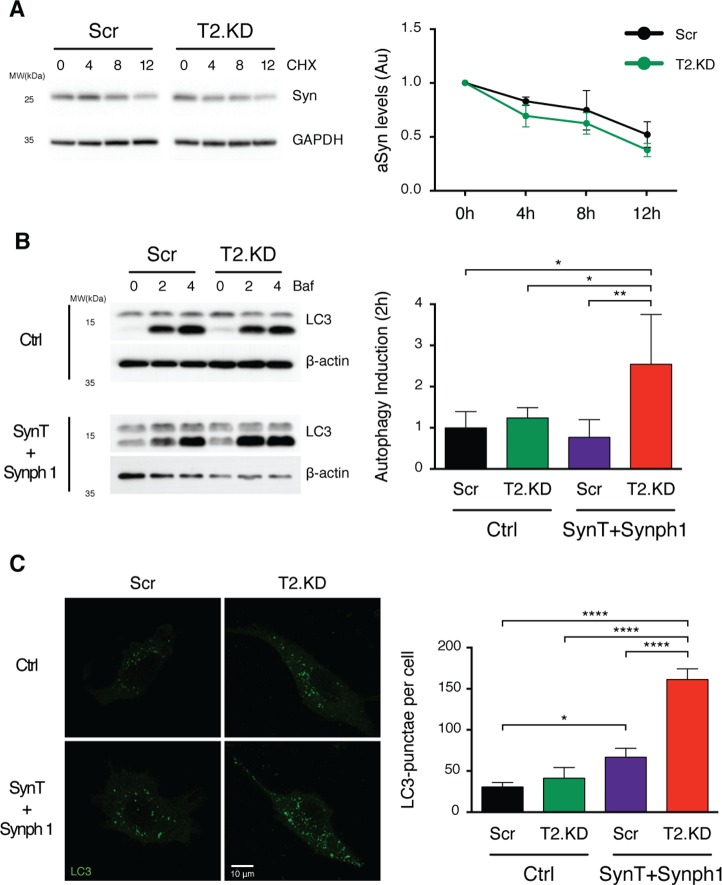
Acetylation of aSyn enhances the clearance of aSyn inclusions by autophagy.(A) H4 cells (control and T2.KD) transiently expressing SynT and synphilin-1 were treated with cycloheximide (CHX) for 4, 8, and 12 h. Protein extracts were then separated on SDS-PAGE and probed for aSyn and GAPDH for normalization (at least n = 3). (B) Cells as in (A) were treated with bafilomycin A1 (BafA) for 2 and 4 h. Protein extracts were probed for LC3 and β-actin. LC3-II levels were normalized to β-actin, and the difference between BafA treatment for 2 h and vehicle (0 h) treatment was calculated (at least n = 3). (C) Cells as in (A) were processed for ICC (LC3, green). Number of LC3 puncta per cell were counted (n = 3). Data in all panels are average ± SD, * p < 0.05, ** p < 0.01. For (B) and (C), ordinary one-way ANOVA with Tukey’s multiple comparisons test. Data in S1 Data.